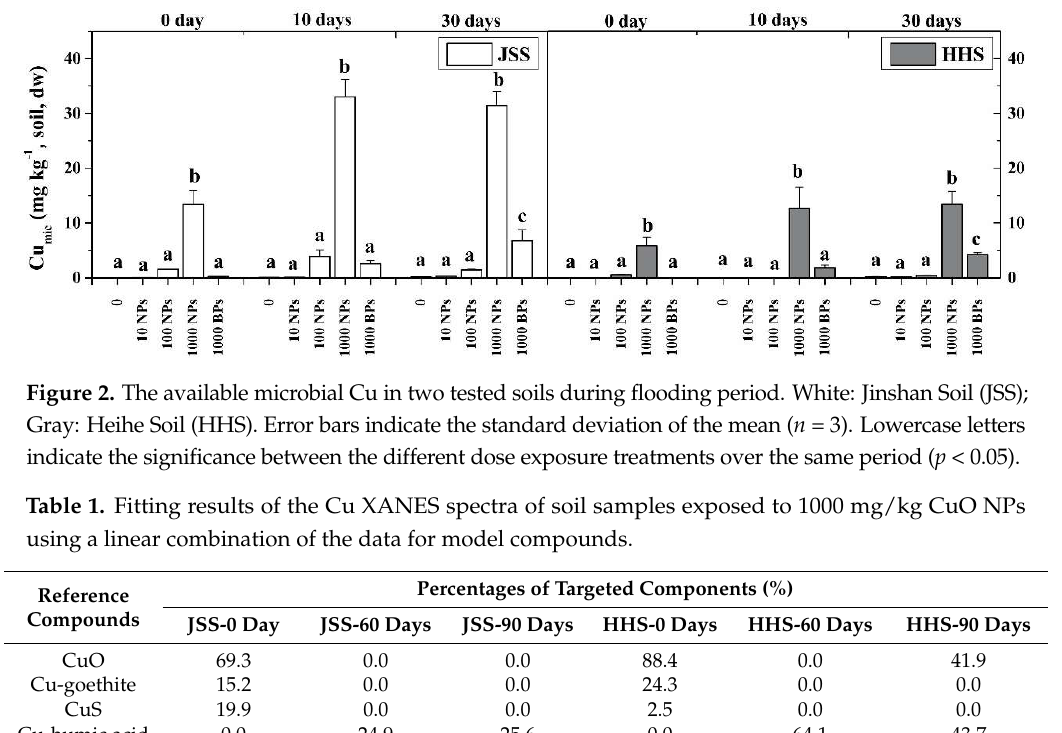
Figure 1. Cu content in the soil extracted by CaCl 2 ( a , b ), and EDTA ( c , d ). White: Jinshan Soil (JSS); Gray: Heihe Soil (HHS). Error bars indicate the standard deviation of the mean ( n = 3). Lowercase letters indicate the significance between the different dose exposure treatments over the same period. Uppercase letters indicate the significance between the different time treatments of the same exposed dosage ( p < 0.05).